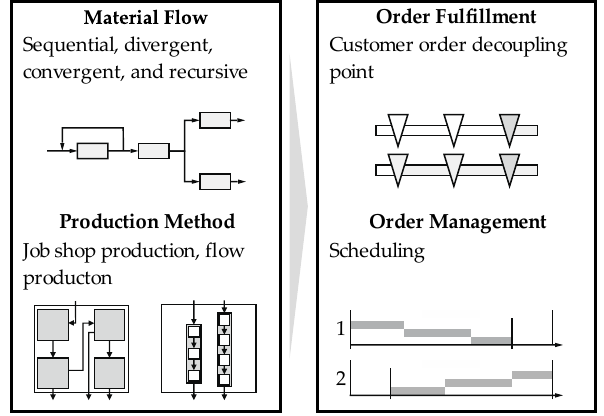
Figure 2. Tasks of production management.